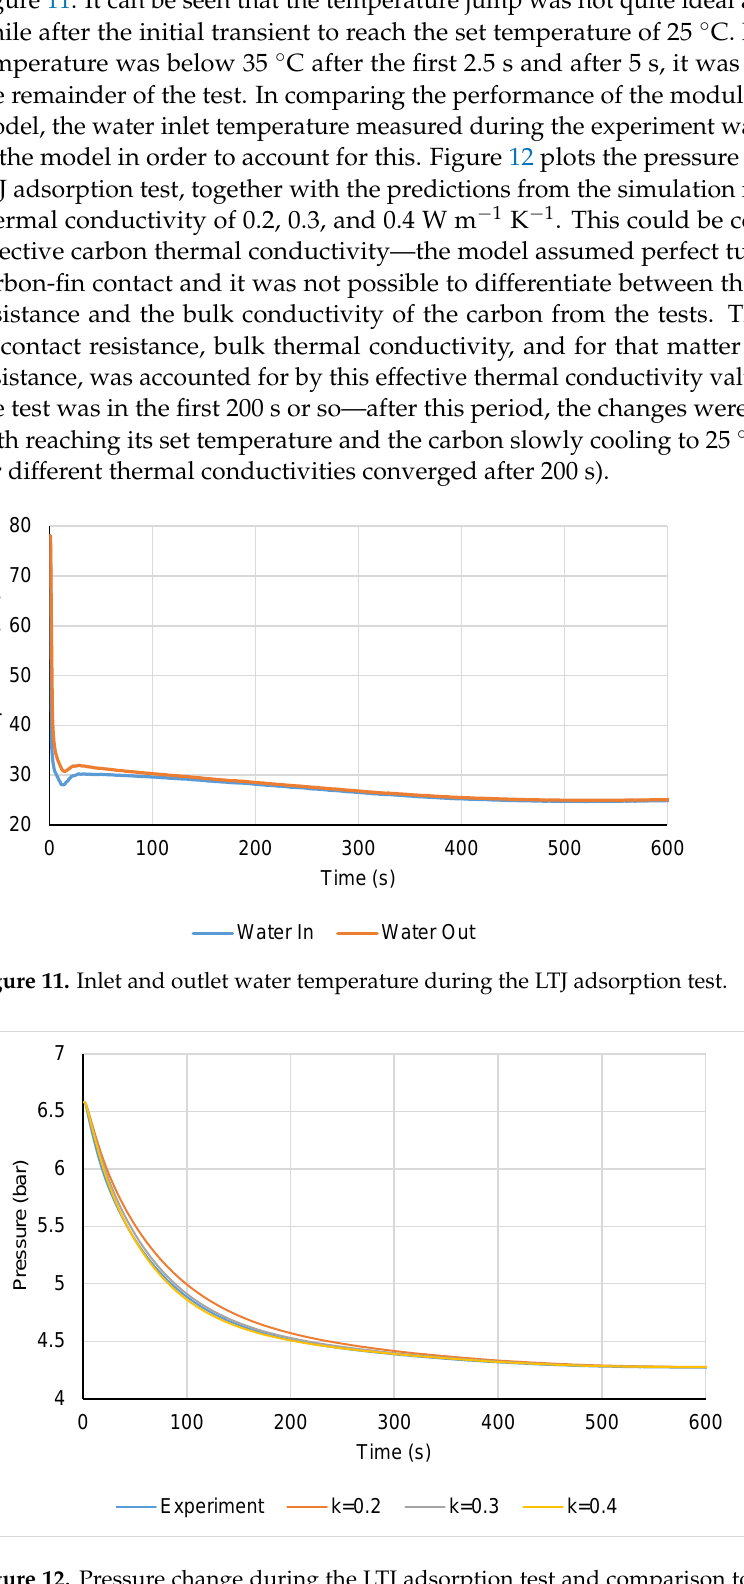
Figure 13. LTJ desorption test pressure change and comparison to model (300-mm module). Running the model with a range of conductivity values between 0.3 and 0.4 W m −1 K −1 , the lowest root mean squared error between the model and experiment was achieved with a conductivity of 0.36 ± 0.01 W m −1 K −1 . The module therefore behaved as expected, with only a slight correction required to the effective thermal conductivity of the carbon